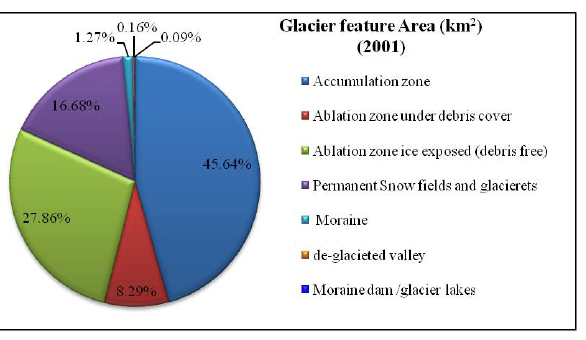
Figure 9: Percent glaciated area under major